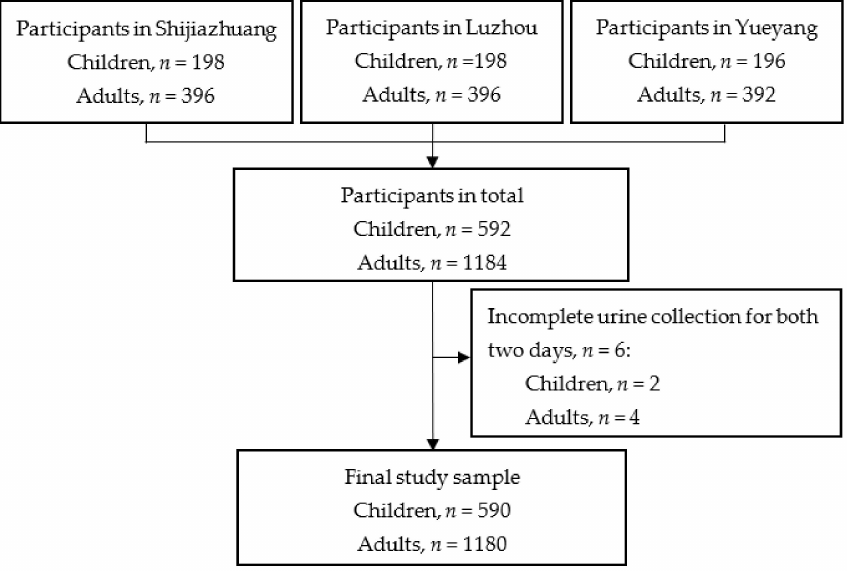
Figure 1. Flow chart of